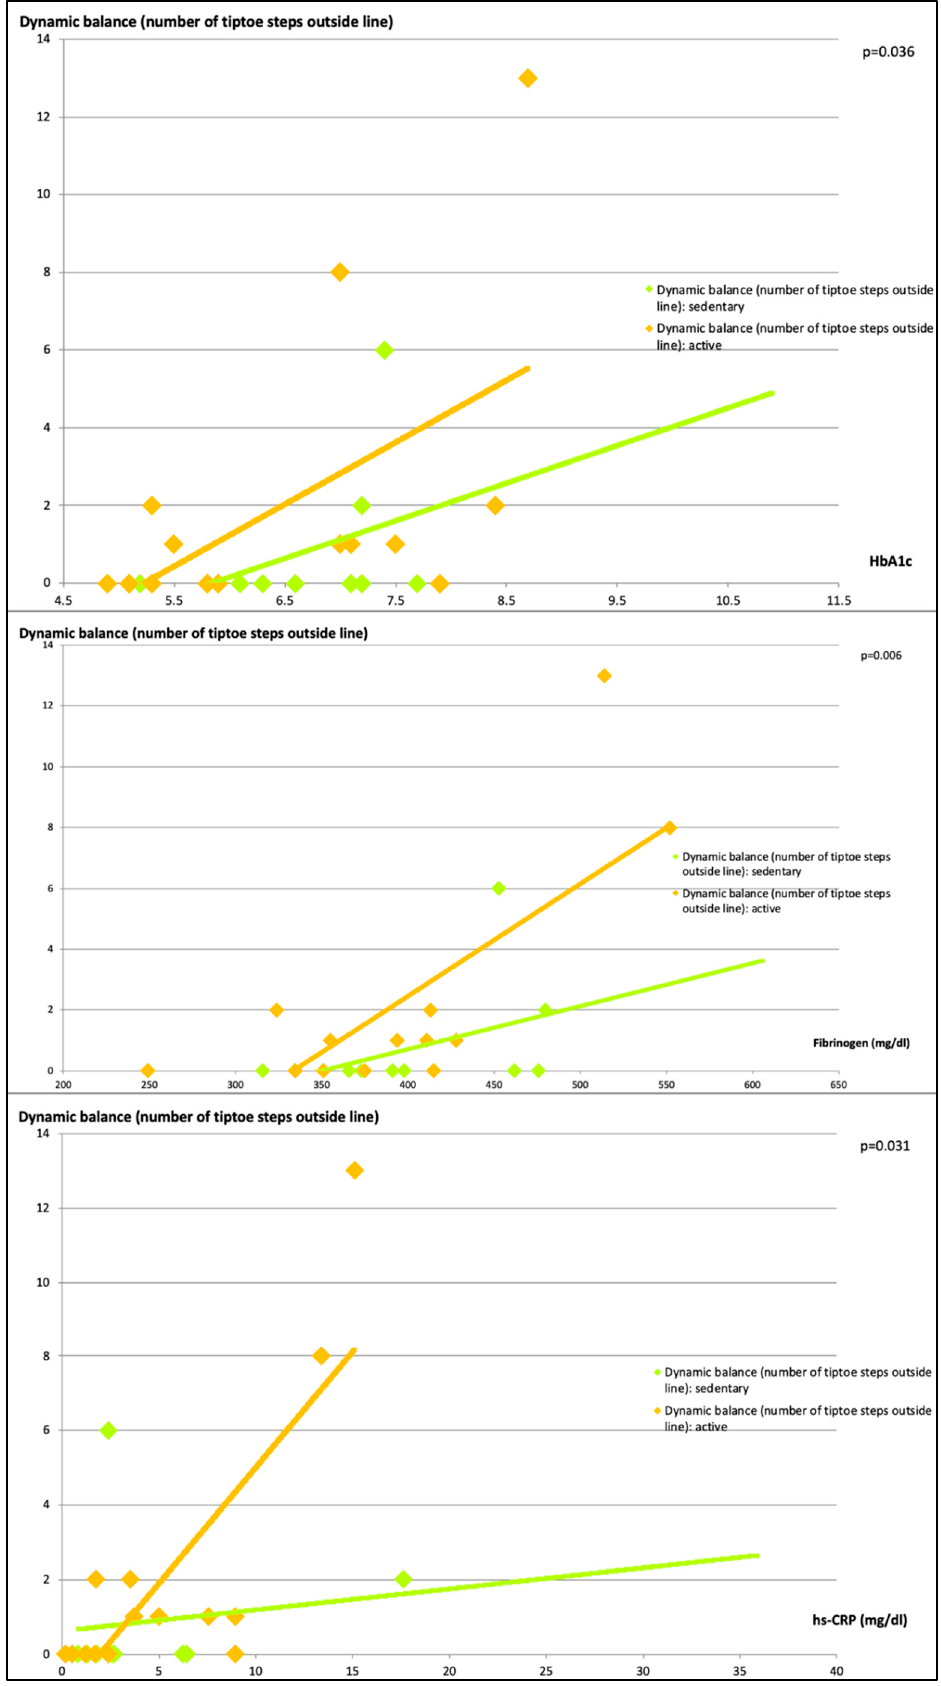
Figure 1. Impaired dynamic balance in subjects with higher HbA1c, fibrinogen and hs-CRP.